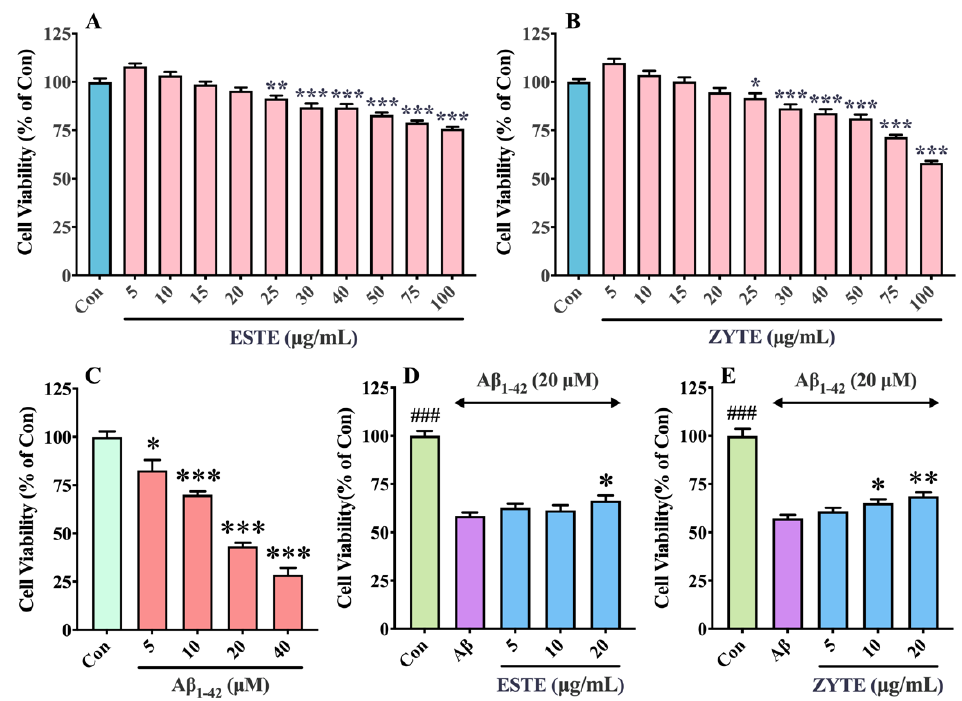
Figure 5. Effects of Se-GTEs on A β 1–42 -induced cytotoxicity in HT22 cells. HT22 cells were treated with different concentrations of Se-GTEs ( A , B ) or A β 1–42 ( C ) for 24 h. HT22 cells were treated with 5–20 µ g/mL of Se-GTEs for 2 h, followed by incubation with 20 µ M of A β 1–42 for 22 h ( D , E ). Cell viability was assessed using the CCK-8 assay. Values are the mean ± SD from three independent experiments, and each one was conducted in triplicate. #: control group vs. A β group; *: A β + Se-GTEs group vs. A β group.; ### p < 0.001, * p < 0.05, ** p < 0.01, and *** p < 0.001, respectively.